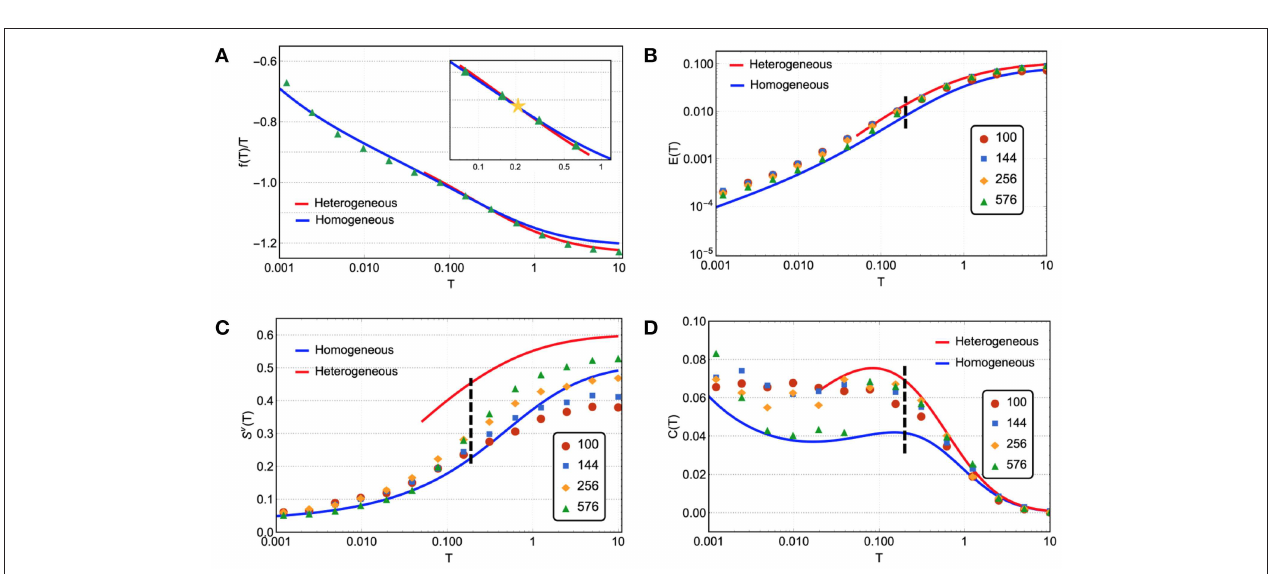
FIGURE 3 | Thermodynamics of the network model near the rigidity transition n = 2.06. The thermodynamics is characterized by the basic thermodynamic quantities, including free energy, internal energy, entropy, and specific heat, shown vs. temperature in markers for simulation results and in curves for analytical predictions. The simulations are done for different system sizes N (see legends) and the analytical predictions are obtained in the thermodynamic limit N → ∞ for homogeneous networks in blue and heterogeneous networks in red (see Supplementary Notes 3 , 4 for detailed descriptions). (A) The numerical results of free energy follow the prediction of a homogeneous network at low temperatures until the homogeneous-heterogeneous first order phase transition around T ≈ 0.2 and then cross over to the prediction of a heterogeneous network. The yellow star in the inset marks this crossover. (B) Data points follow the homogeneous and heterogeneous predictions in the same low and high temperature ranges corresponding to the free energy, while separated by a discrete transition that the numeric result is converging to in the thermodynamic limit. (C) Similarly, the vibrational entropy results also converge to a discrete jump at the crossover of free energy. (D) At the phase transition, the specific heat is also characterized by has a jump, seen in the largest system